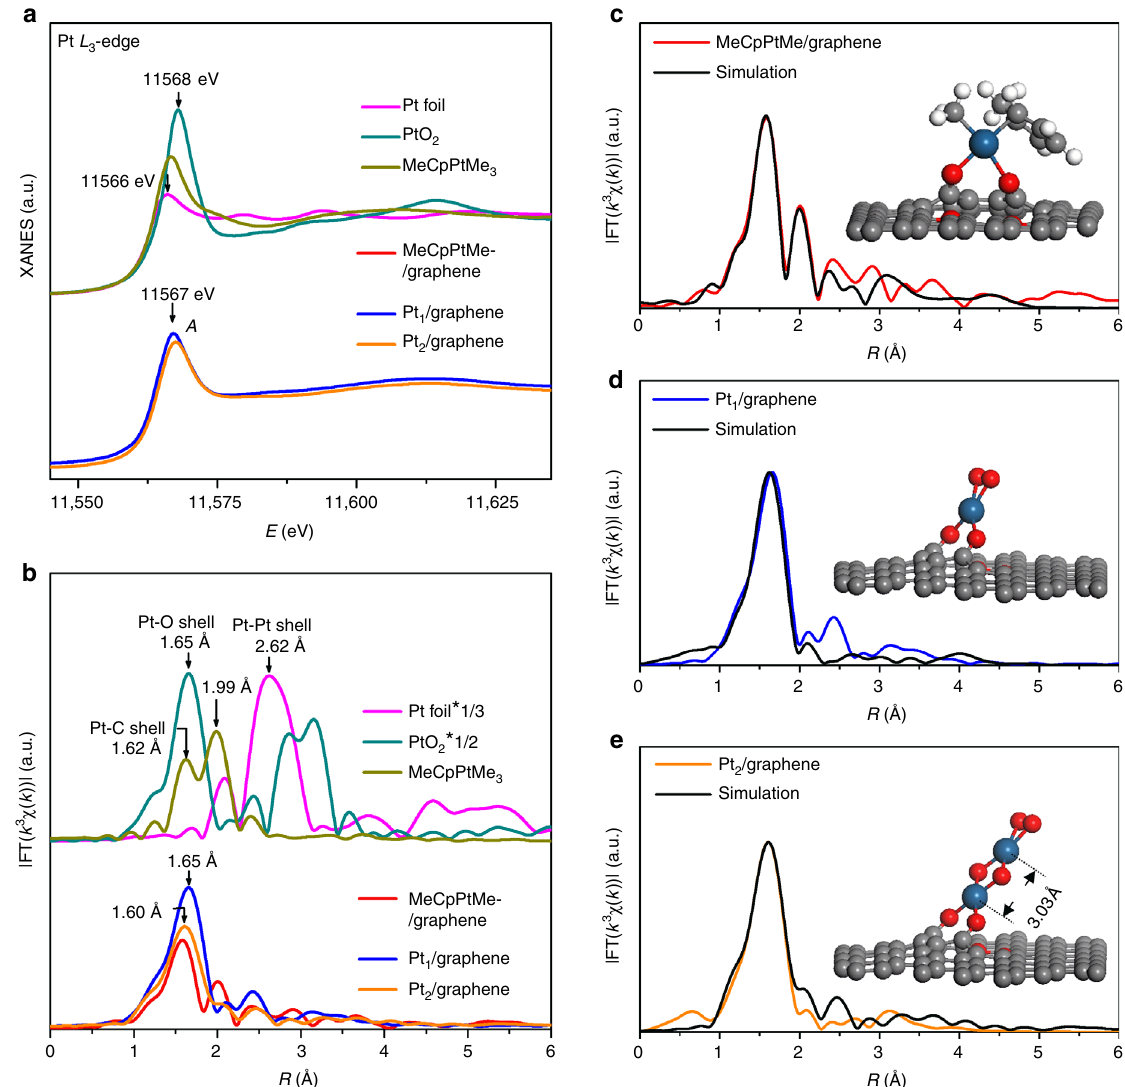
Fig. 3 XAFS structural characterization and spectra simulations. a The XANE spectra and b the K 2 -weighted Fourier transform spectra of MeCpPtMe/ graphene, Pt 1 /graphene, and Pt 2 /graphene at the Pt L 3 -edge. The reference samples of Pt foil, PtO 2 , and MeCpPtMe 3 are also shown for comparison. Comparison of the EXAFS simulations based on the corresponding DFT calculated structural models (insets) with the experimental EXAFS spectra of MeCpPtMe/graphene ( c ), Pt 1 /graphene ( d ) and Pt 2 /graphene ( e ). The ball in gray, white, red, and dark blue represent carbon, hydrogen, oxygen,